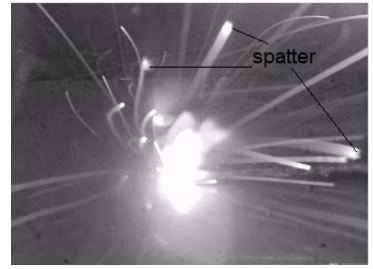
Figure 3. High ‐ speed photographs of spatter formation during laser welding. Figure 3. High-speed photographs of spatter formation during laser welding.